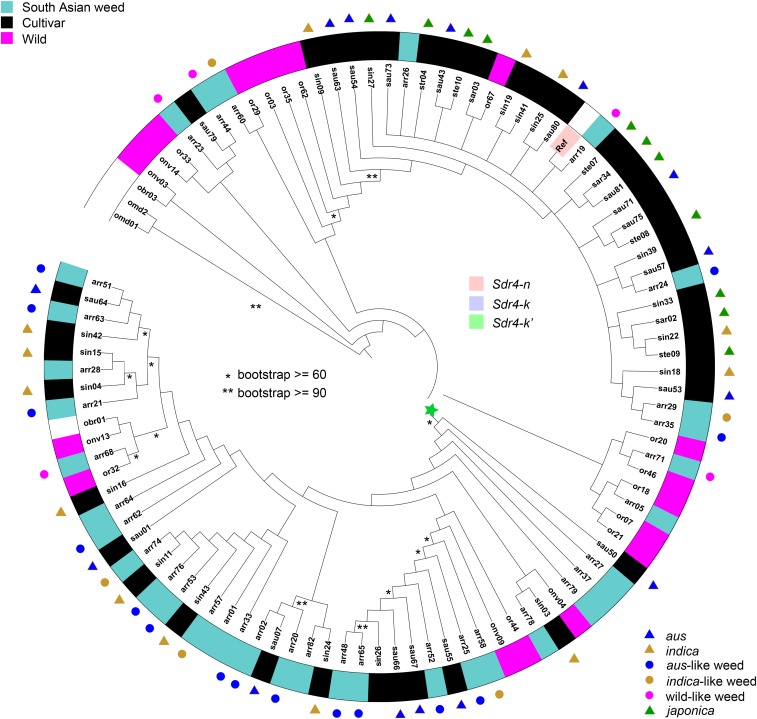
Neighbor joining (NJ) tree of Sdr4 haplotypes. The color range indicates the three Sdr4 haplotypes identified in Sugimoto et al. (2010). The ring and the bullets indicate Oryza groups, as labeled in the key. Unmarked weeds are admixed according to results of Huang et al. (2017). Asterisks on branches indicate bootstrap values as labeled.